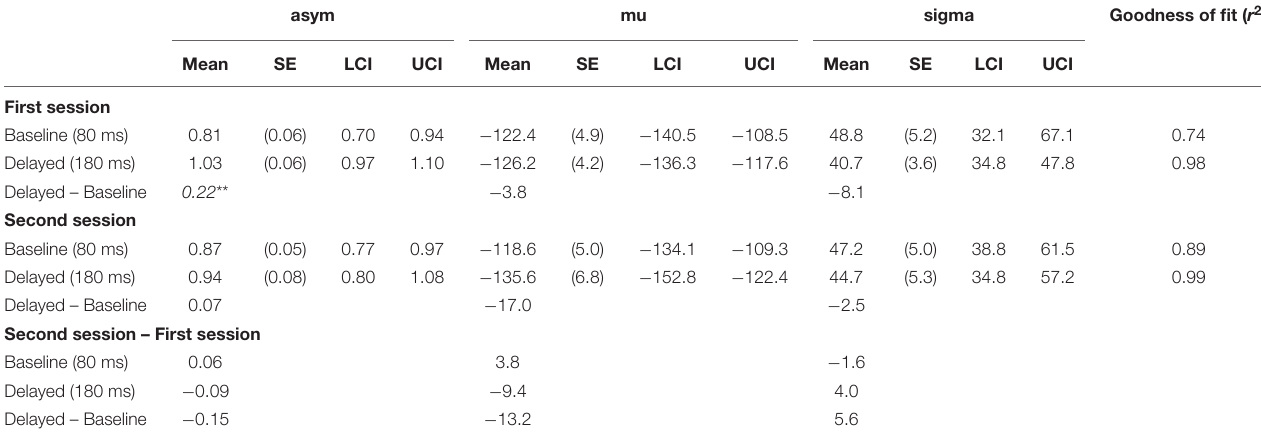
TABLE 3 | Estimated parameter values of the fitted psychometric curve of the mean rate of “self” response against the mean asynchrony. asym mu sigma Goodness of fit ( r 2